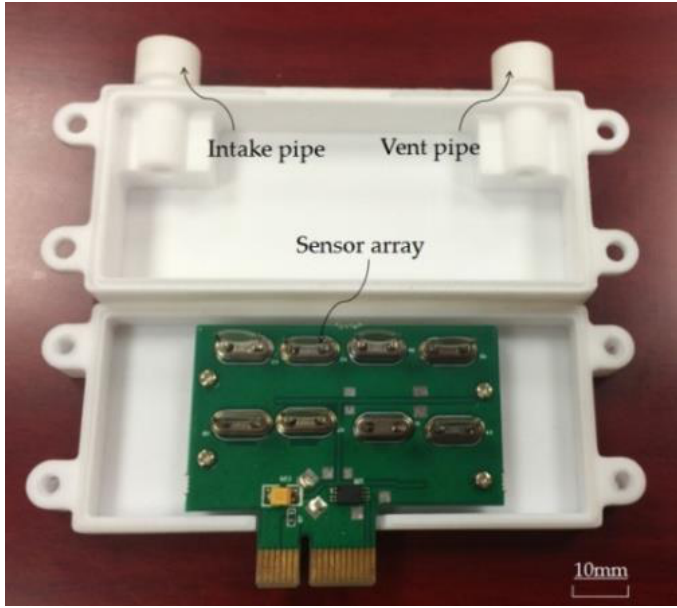
Figure 6. Photo of the sensor box. Table 2. Composition of the eight sensor coatings in the sensor array.